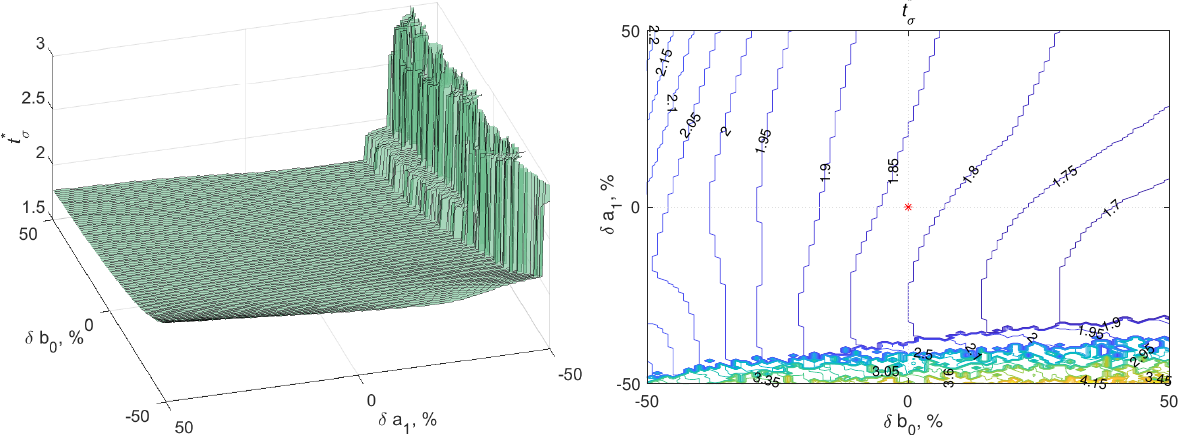
Figure 16. Simulations results. Dependence of t ∗ σ on plant model parameters a 1 , b 0 , varying on ± 50 %; γ = 1000, γ = 500, ω ∗ = 60 rad/s, ψ ∗ = π . Left : 3D plot, right : contour plot; asterisk (cid:63) is I for “nominal”